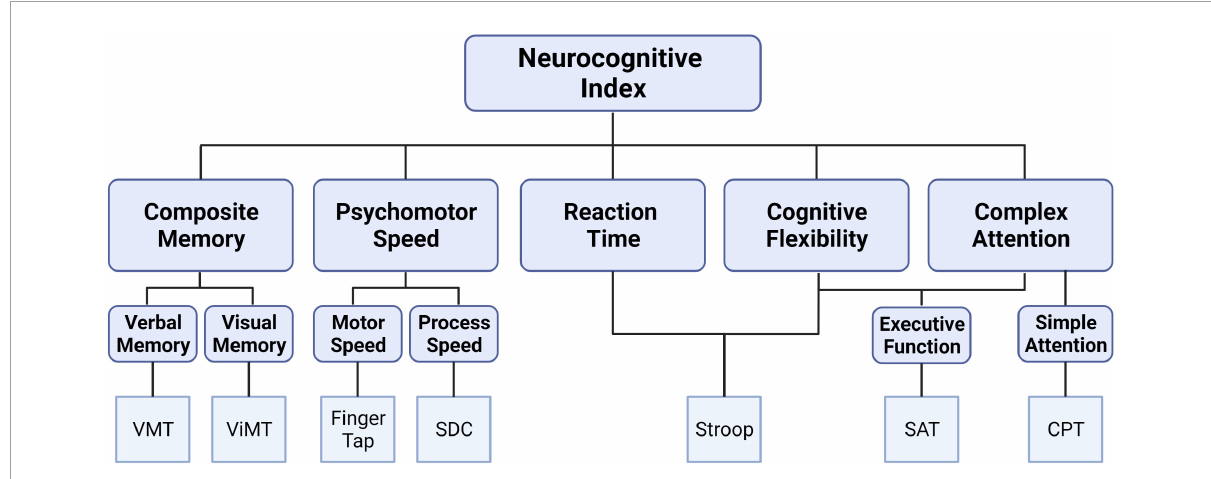
FIGURE1 Schematic depicting the CNS Vital Signs brief-core battery testing a broad spectrum of cognitive domains from seven, discrete tests: verbal memory test (VMT), visual memory test (ViMT), finger tapping test, symbol digit coding (SDC), Stroop test, shifting attention test (SAT), and continuous performance test